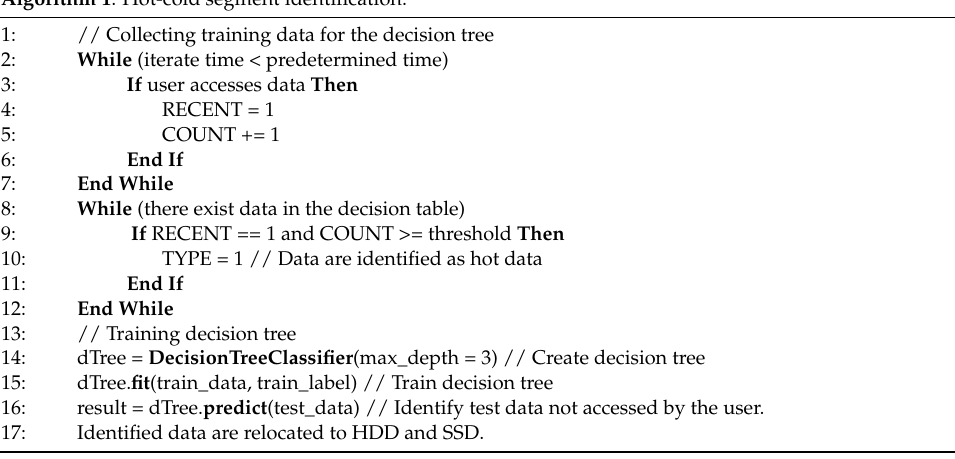
Algorithm 1 . Hot-cold segment